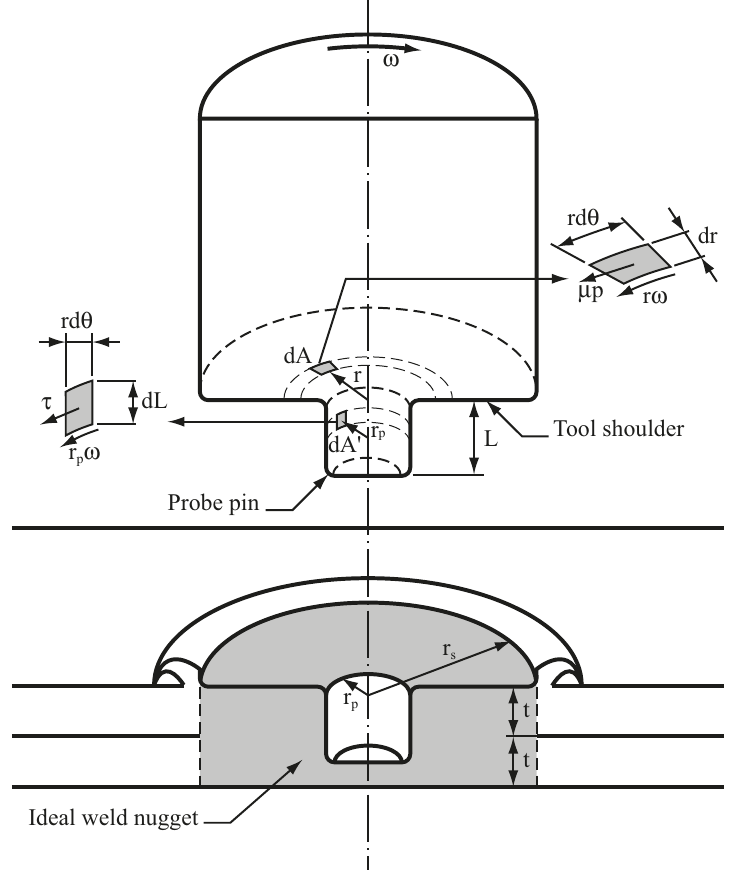
Figure 1. Schematic plots of the halves of an extracted weld tool and an ideal FSSW.